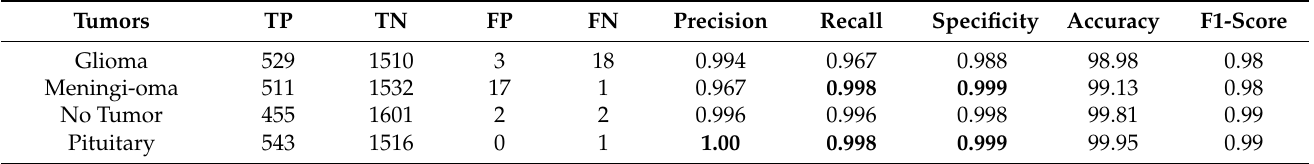
Table 4. Performance analysis of the proposed model.